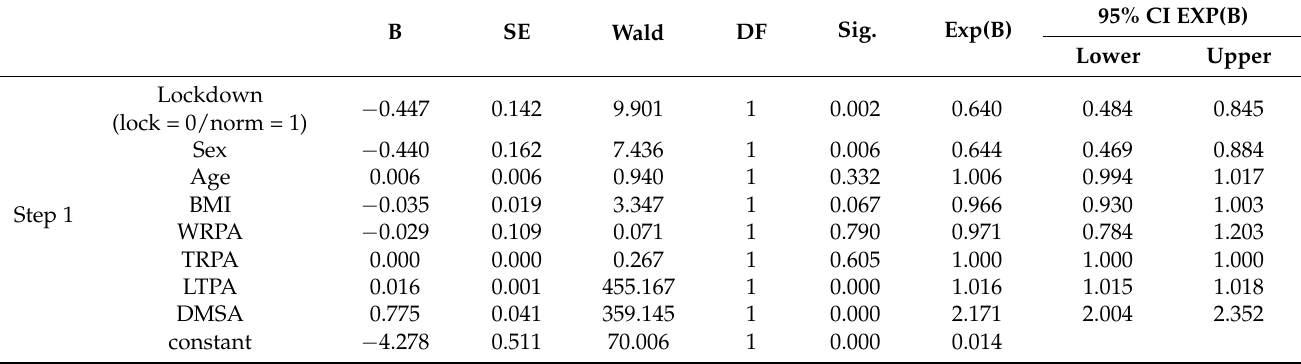
Table 9. Binary logistic regression model with odds ratios (95% CI) for the explanation of compliance with WHO PA recommendations including sex, age, BMI, WRPA, TRPA, LTPA, and DMSA, and the categorical variable “lockdown vs. normal”